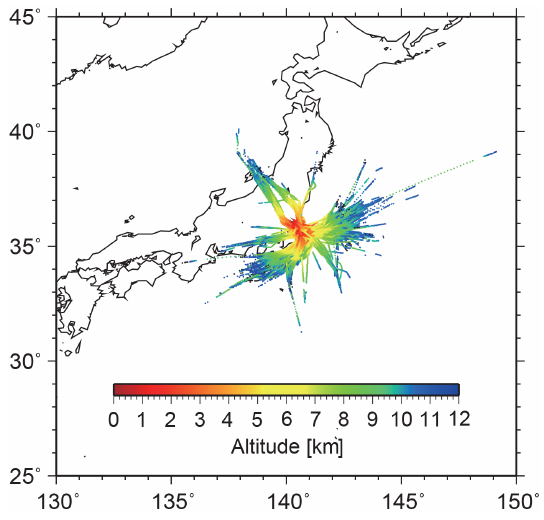
Figure 2. Flight tracks of all CME ascending and descending ob- servations over Narita airport in 2010. Color indicates the altitude levels of each flight. Figure 3. (a) Black circles represent original CME data (CME_raw); the red line shows an interpolated profile of the CME data into 28 GOSAT/TANSO-FTS TIR CO 2 retrieval grid layers (CME_obs); the blue line shows the interpolated profile to which TIR averaging kernel functions, shown in panel (b) , are applied (CME_AK); and the green line shows a priori CO 2